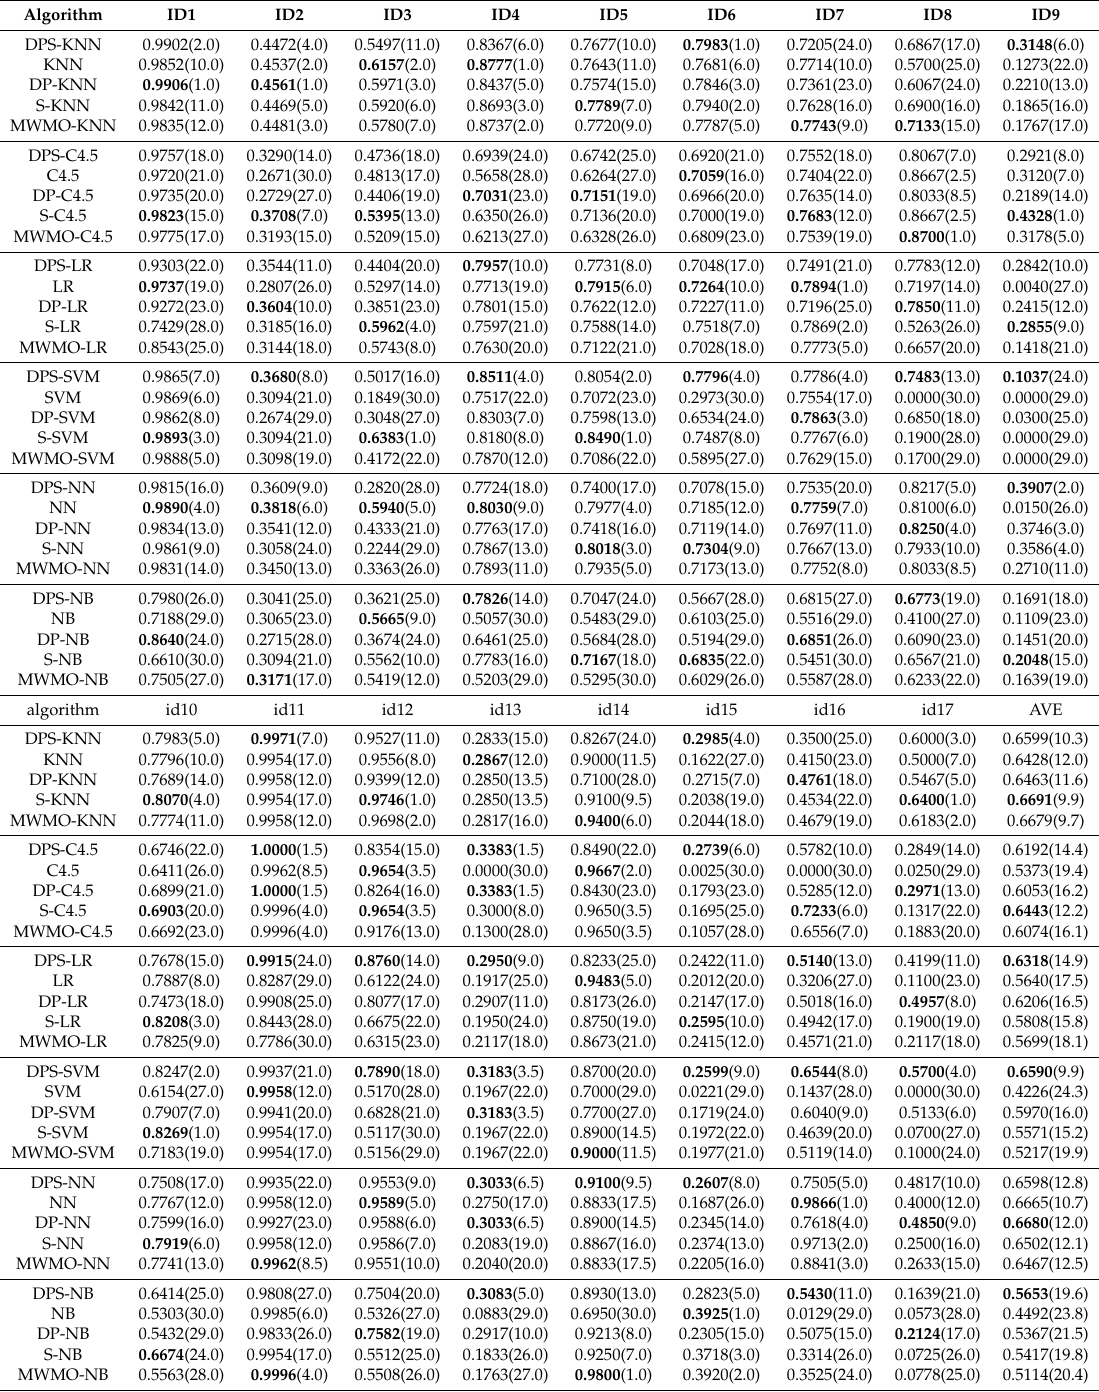
Table 5. Experimental results of models on f-measure